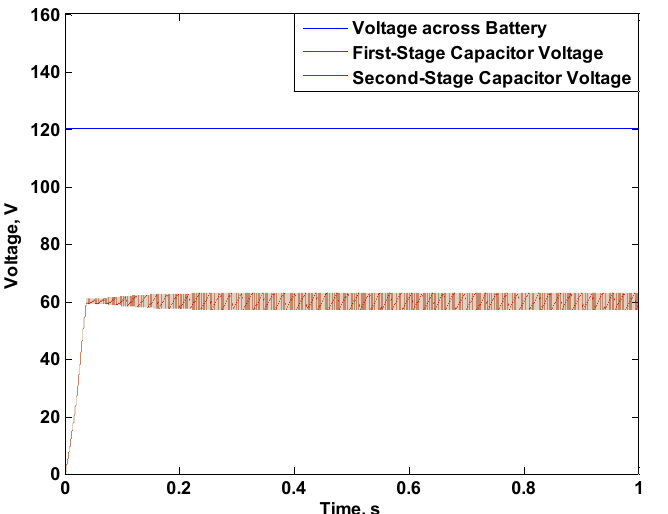
Figure 21. Output, first-stage capacitor and second-stage capacitor voltages at a reference current of 2 A.